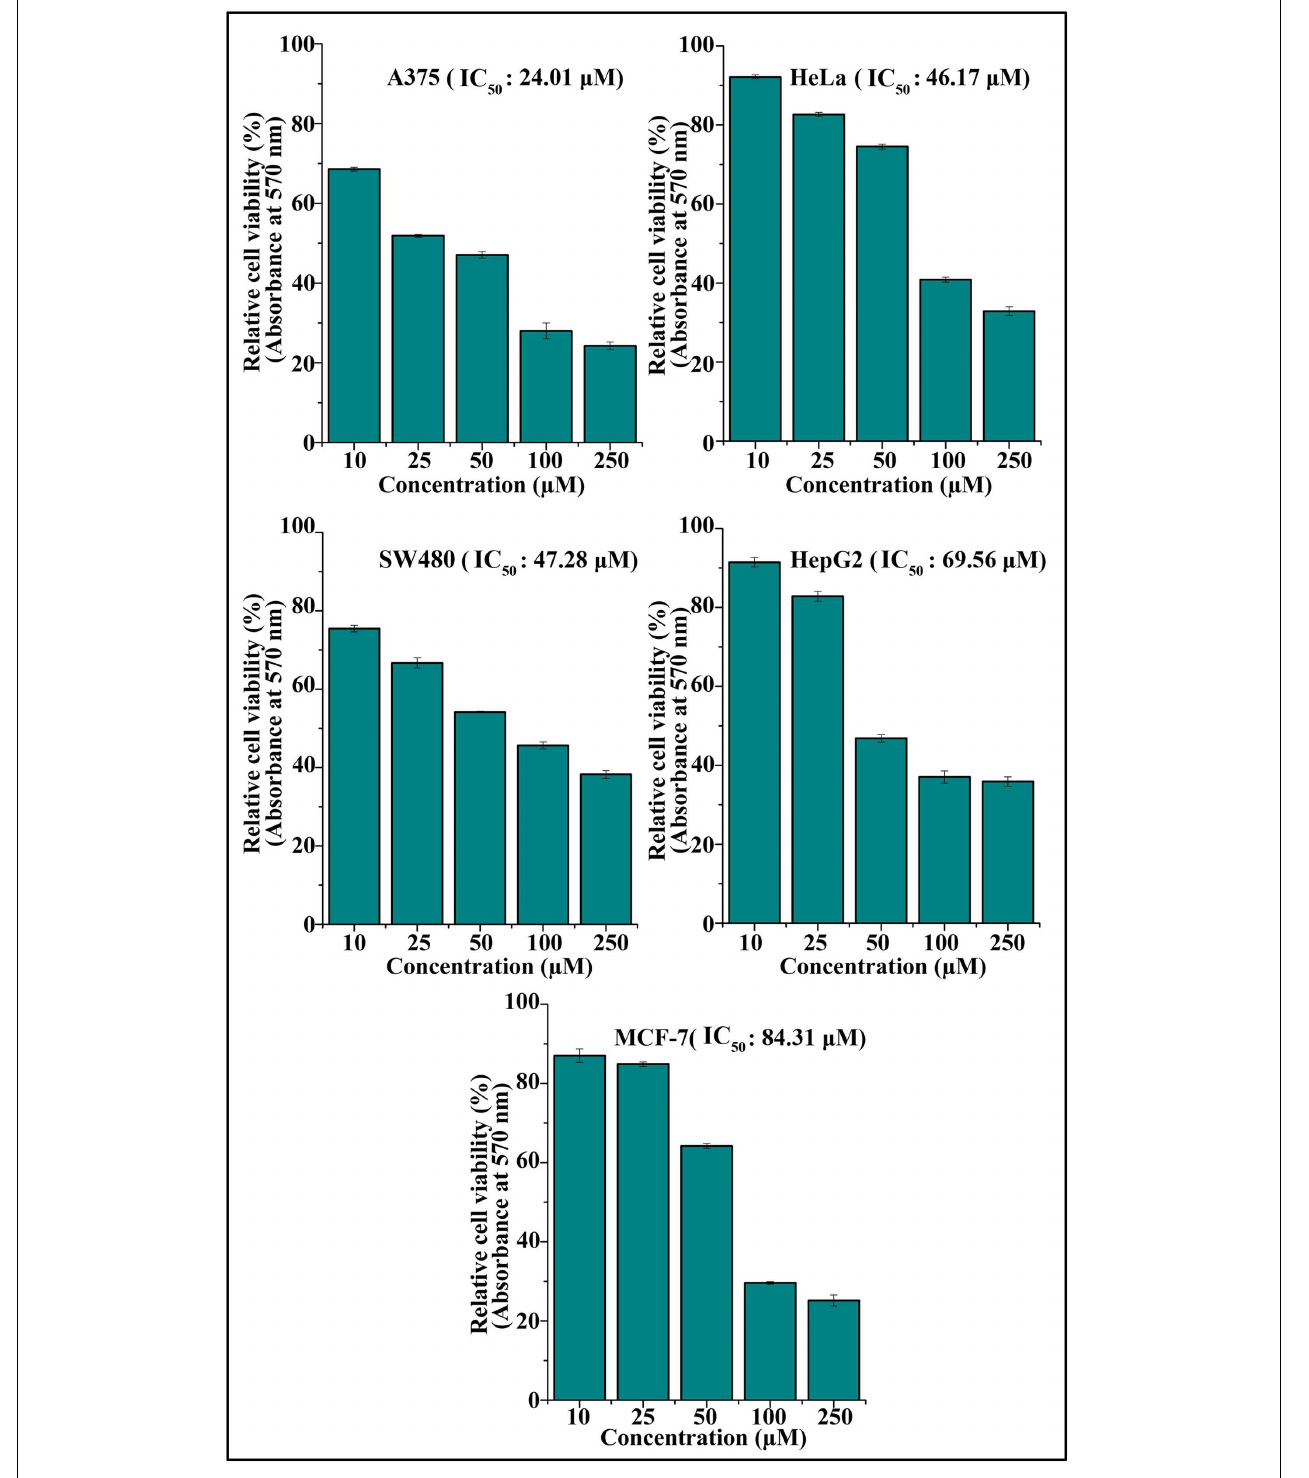
FIGURE 2 | DETS induces maximum cytotoxicity in skin cancer cells. Effect of DETS on cancer cells of various origin. A total of 2000 cells in triplicate were exposed to the indicated concentration of DETS (10–250 µ M) for 48 h and subjected to MTT assay. Relative cell viability was determined as % absorbances over untreated control. All the measurements were done in three replicates and results are expressed as arithmetic mean ± standard error on the mean. Different letters in the superscript were significantly different according to Duncan’s multiple range test ( p < 0.05).